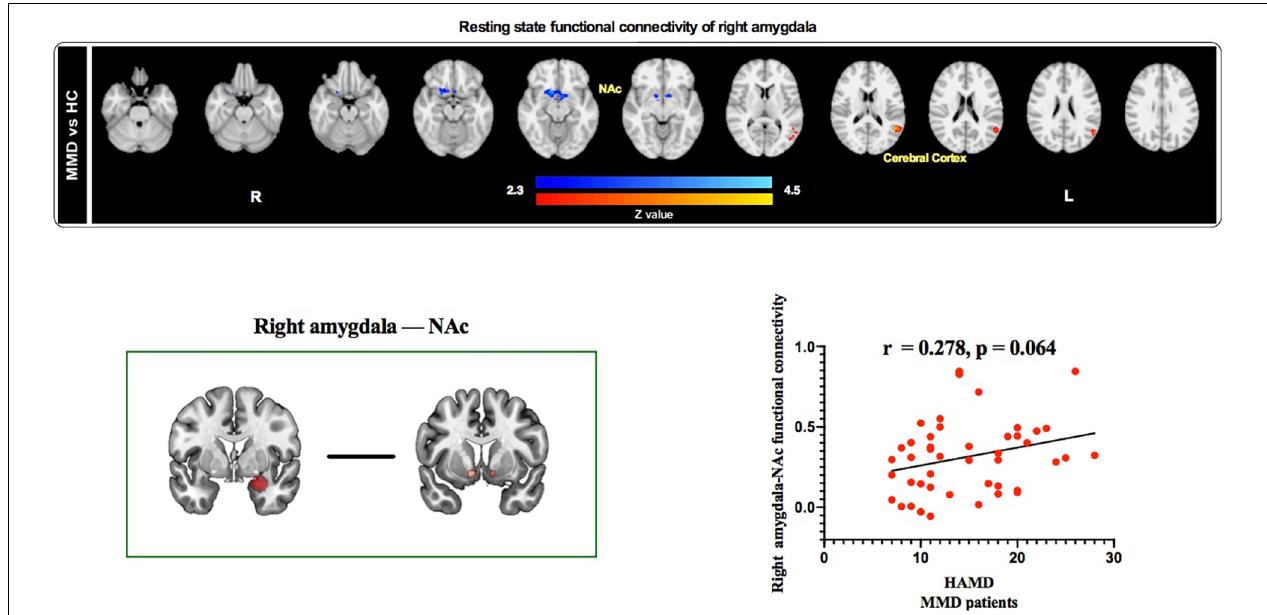
FIGURE 4 | Resting state functional connectivity of right amygdala and correlation between right amygdala-based functional connectivity and HAMD scores in MMD patients. Top panel: The right amygdala exhibited weaker resting state functional connectivity with the NAc and stronger resting state functional connectivity with the cerebral cortex in MMD patients than in HCs. Bottom panel: Resting state functional connectivity between right amygdala and NAc was positively correlated with HAMD scores in MMD patients (marginal significant). NAc, Nucleus accumbens; HAMD, Hamilton Depression; MMD, mild-to-moderate depression; HCs, Healthy Controls.